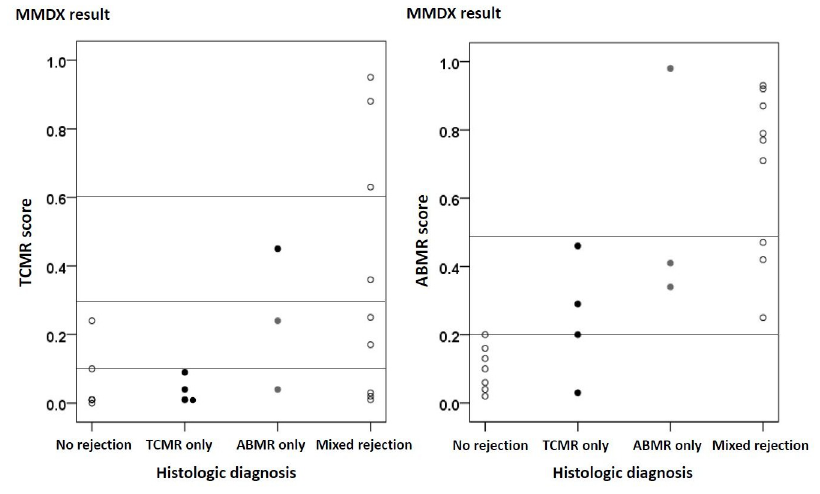
Fig 4. Association between the molecular microscope diagnostic system and the histological diagnosis.